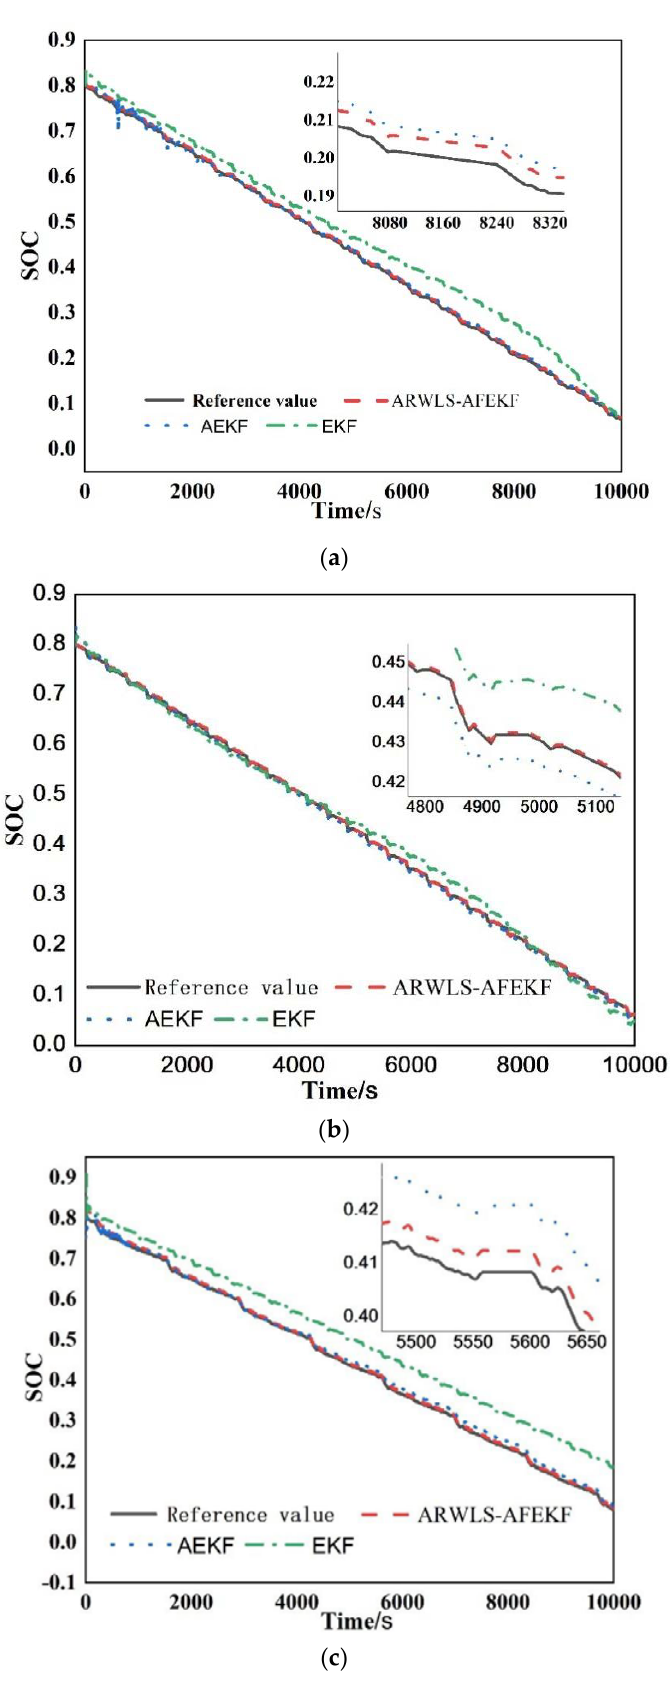
Figure 6. SOC estimation under BJDST25 ( a ), DST25 ( b ), and FUDS25 ( c ) operating conditions.